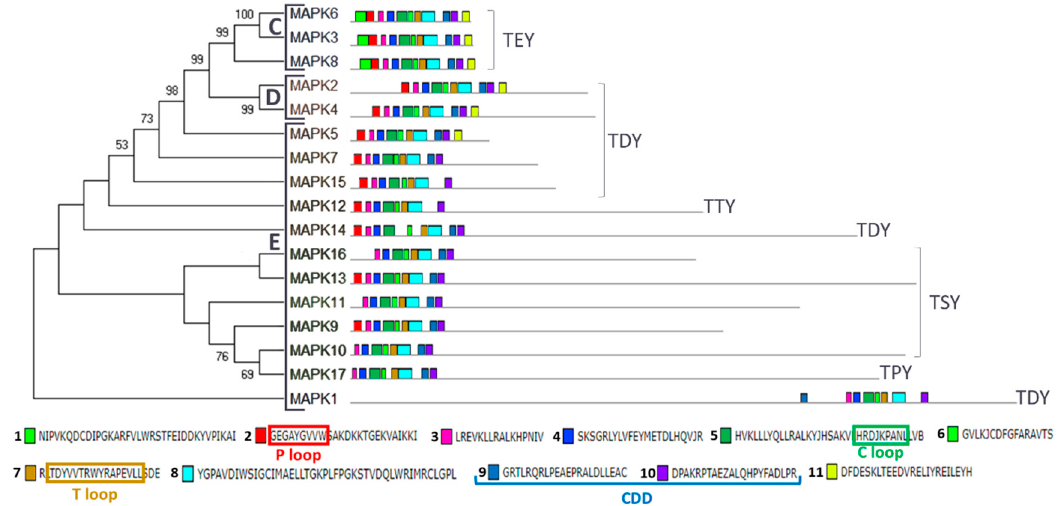
Figure 2. Phylogenetic and motif analysis of MAPK family. The MAPKs classified by maximum likelihood phylogenetic analysis is shown on the left. Numbers on branches indicate percent bootstraps values. Bootstrap values above 50%, based on 1000 replicates, are shown. On the right, the analysis of their domains identified with the MEME program. Below the conserved sequence of the 11 identified domains listed in order of appearance from the N-terminal domain. The P, C and T loops and the CDD are highlighted in colored rectangles. Capital letters indicate the different phylogenetic groups.